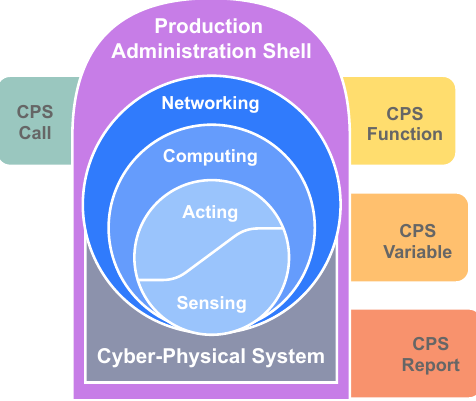
Figure 6. Production Administration Shell for CPS modeling and